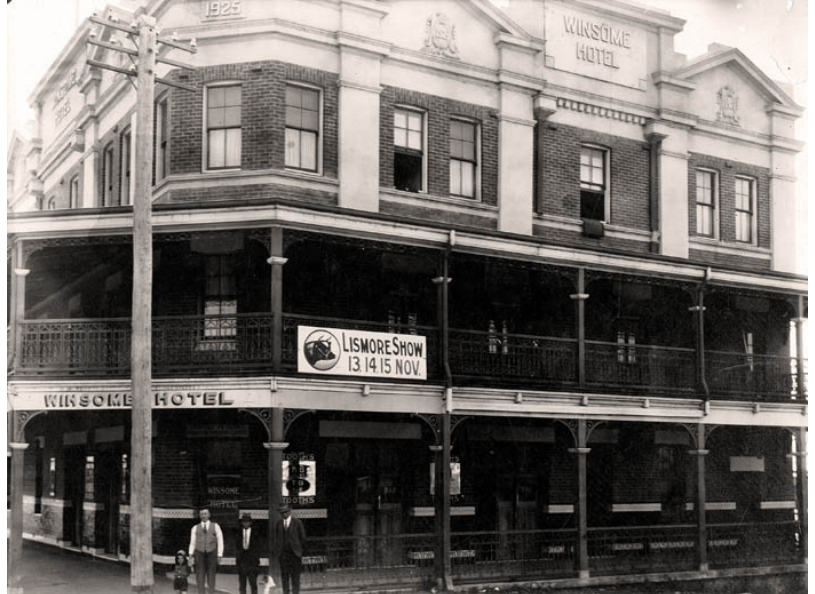
Figure 5: The Winsome